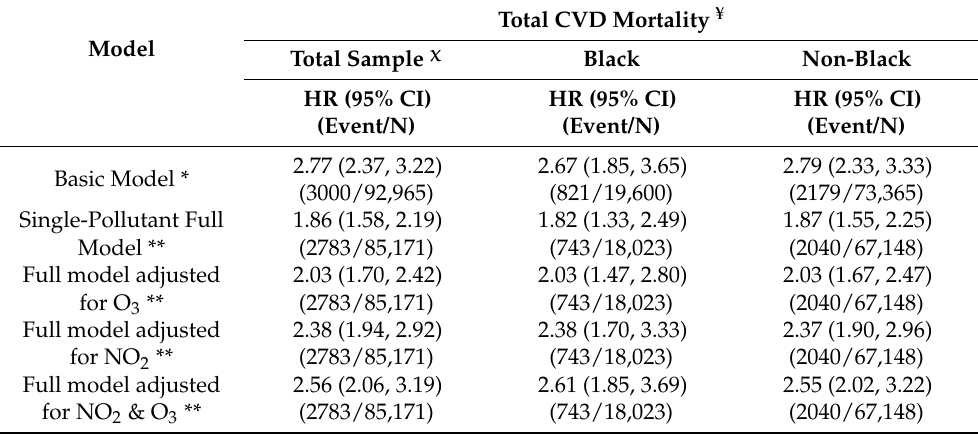
Table 3. Multivariable-Adjusted Hazard Ratios for Total CVD Fatal Events per 10 µ g/m 3 Increment of PM 2.5 : Single-Pollutant and Two-Pollutant Models by